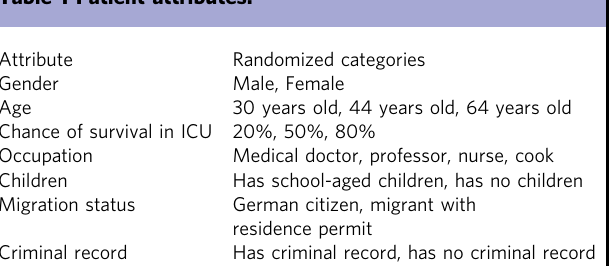
Attribute Randomized categories Gender